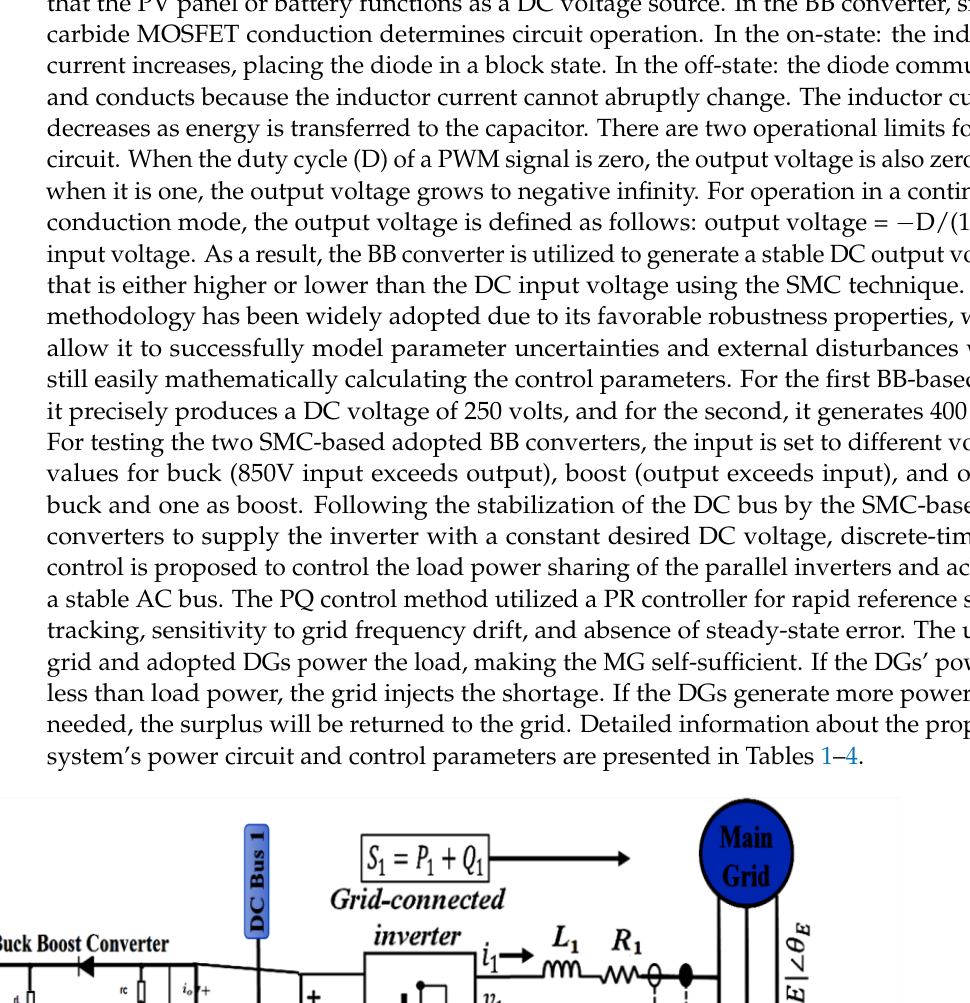
Figure 4. The SMC process works (1): ( a ) reaching phase, ( b ) sliding phase; trajectory movement according to hitting (2) and existence (3) conditions. 4.1.1. Control Gain Parameters of SMC The schematic diagram in Figure 5 depicts a PID-based sliding mode voltage-con- trolled BB converter [30], where L , C , and R L are the inductance, capacitance, and instan- taneous load resistance of the DC/DC converter. The instantaneous currents of the induct- ance, capacitance, and load are denoted by 𝑖 𝐿 , 𝑖 𝐶 , and 𝑖 𝑟 , respectively. The instantaneous input voltage is denoted by 𝑣 𝑖 , the reference voltage is represented by 𝑉 𝑟𝑒𝑓 , and the sensed output voltage is denoted by 𝛽𝑣 𝑜 , where 𝛽 =